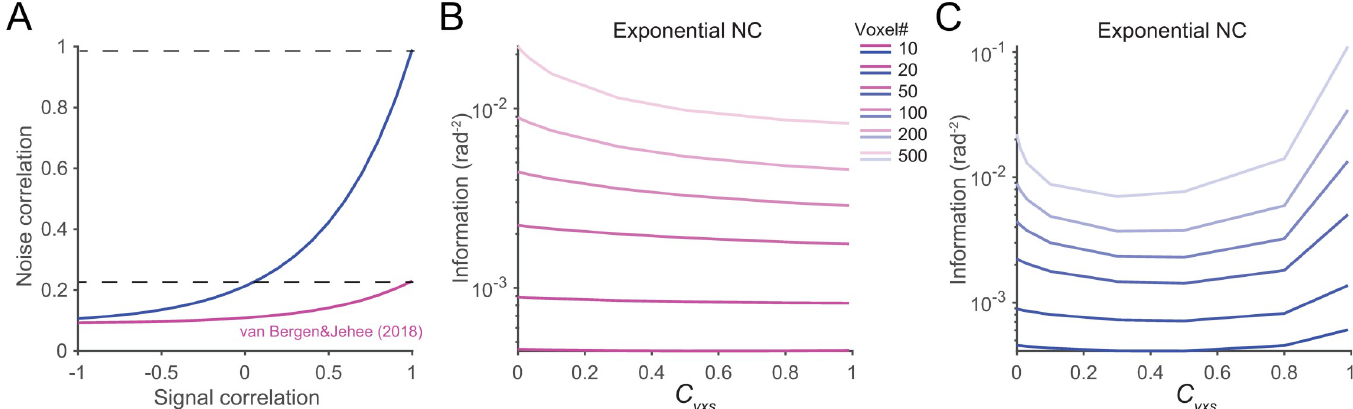
Fig 10. Simulation of voxel population responses based2 on realistic fMRI data. A . noise correlation as an exponential function of signal correlation. The magenta curve is estimated from van Bergen and Jehee [22] and we scale it to increase the magnitude of noise correlations (i.e., the blue curve). B , C . simulated effects of noise correlations in the regimes of the magenta and the blue curves, respectively. Noise correlations reduce the amount of information because the overall magnitude is relatively week (i.e., the magenta curve). We again observe U-shaped functions if the overall magnitude of noise correlations are large (i.e., the blue curve).